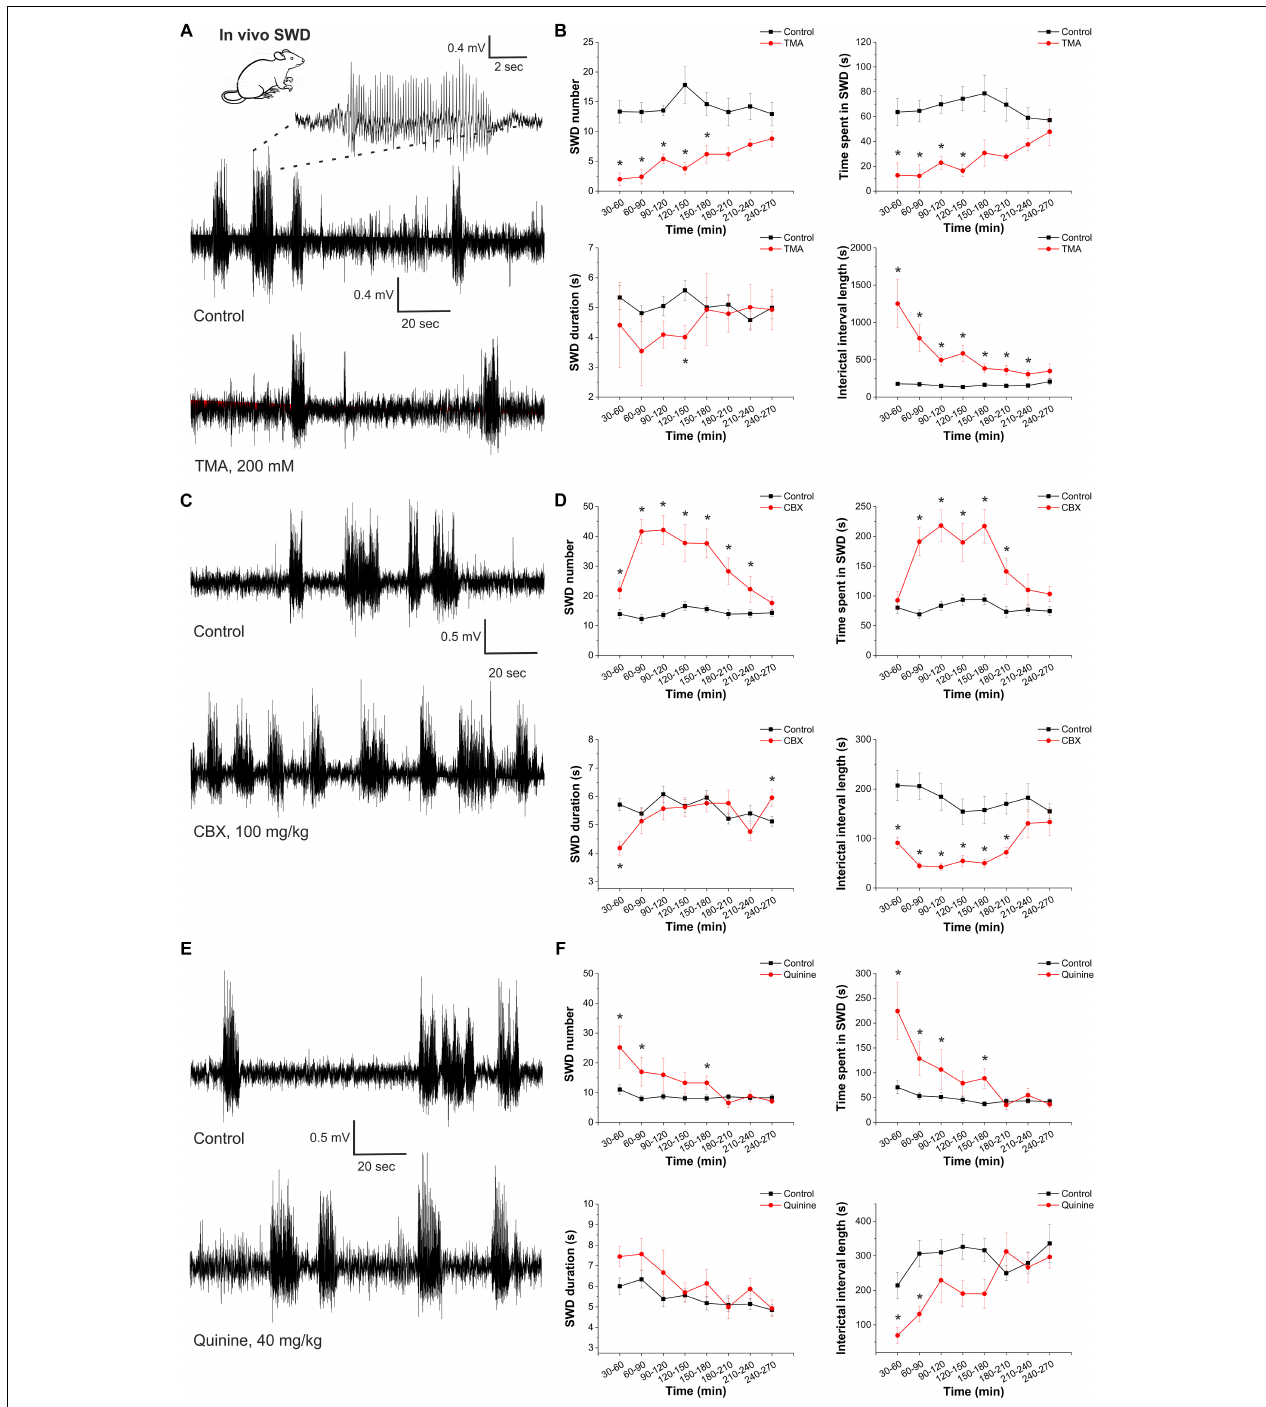
FIGURE 3 | Gap junction activation suppresses, gap junction inhibition enhances the appearance of spike-and-wave discharges in the in vivo absence epilepsy model WAG/Rij rat. (A) EEG recordings of WAG/Rij rats after i.p. saline injection (control) and TMA administration (i.c.v. 200 mM TMA in 5 µ l aseptic ACSF/rat) (left). A typical SWD is shown in higher resolution (above). (B) Effect of TMA on SWD number, total SWD time (time spent in SWD), average SWD duration and length of interictal interval (control: black; treated with TMA: red) ( n = 5 animals). (C) EEG recordings of WAG/Rij rats after i.p. saline injection (control) and CBX administration (i.p. 100 mg/kg). (D) Effect of CBX on SWD number, total SWD time (time spent in SWD), average SWD duration and length of interictal interval (control: black; treated with CBX: red) ( n = 8 animals). (E) EEG recordings of WAG/Rij rats after i.p. saline injection (control) and quinine administration (i.p. 40 mg/kg). (F) Effect of quinine on SWD number, total SWD time (time spent in SWD), average SWD duration and length of interictal interval (control: black; treated with quinine: red) ( n = 7 animals).